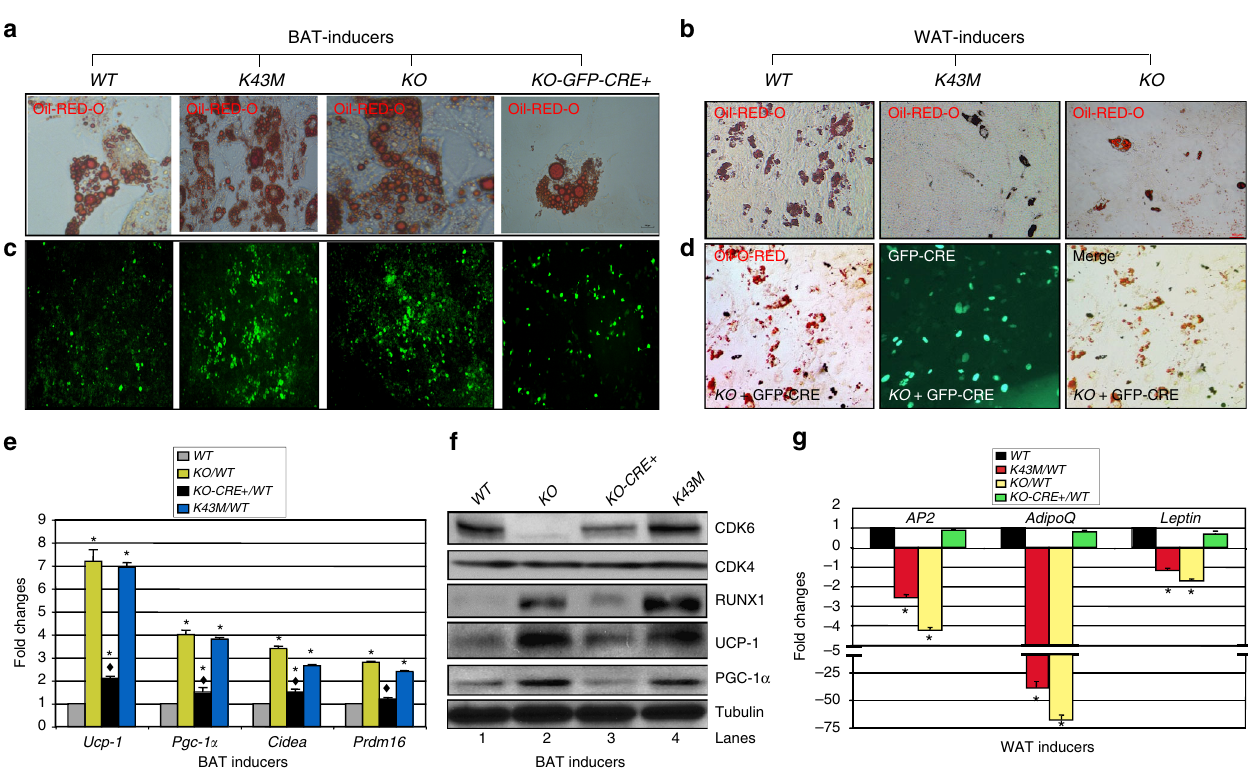
Fig. 6 Re-expression of CDK6 in precursors of KO cells inhibits differentiation towards brown-like adipocytes. a , b , d Representative images of Oil Red O staining of differentiated SVF cells in the presence of BAT inducers ( a ) or WAT inducers ( b , d ). c Representative images of MitoTracker green staining of differentiated SVF cells from iWAT with BAT inducers. MitoTracker green is a cell-permeable probe to label mitochondria. e, g Relative mRNA levels of BAT-speci fi c markers ( e ) and WAT markers ( g ) in the differentiated SVF cells in the presence of BAT or WAT inducers, respectively. Data shown are mRNA fold change normalized to the relative WT controls, which was arbitrarily de fi ned as 1 unit, * p < 0.05, vs WT , t -test ( n = 6). f Immunoblots of the indicated protein levels in differentiated cells from 50 μ g of cell lysates. We used α -tubulin as an internal loading